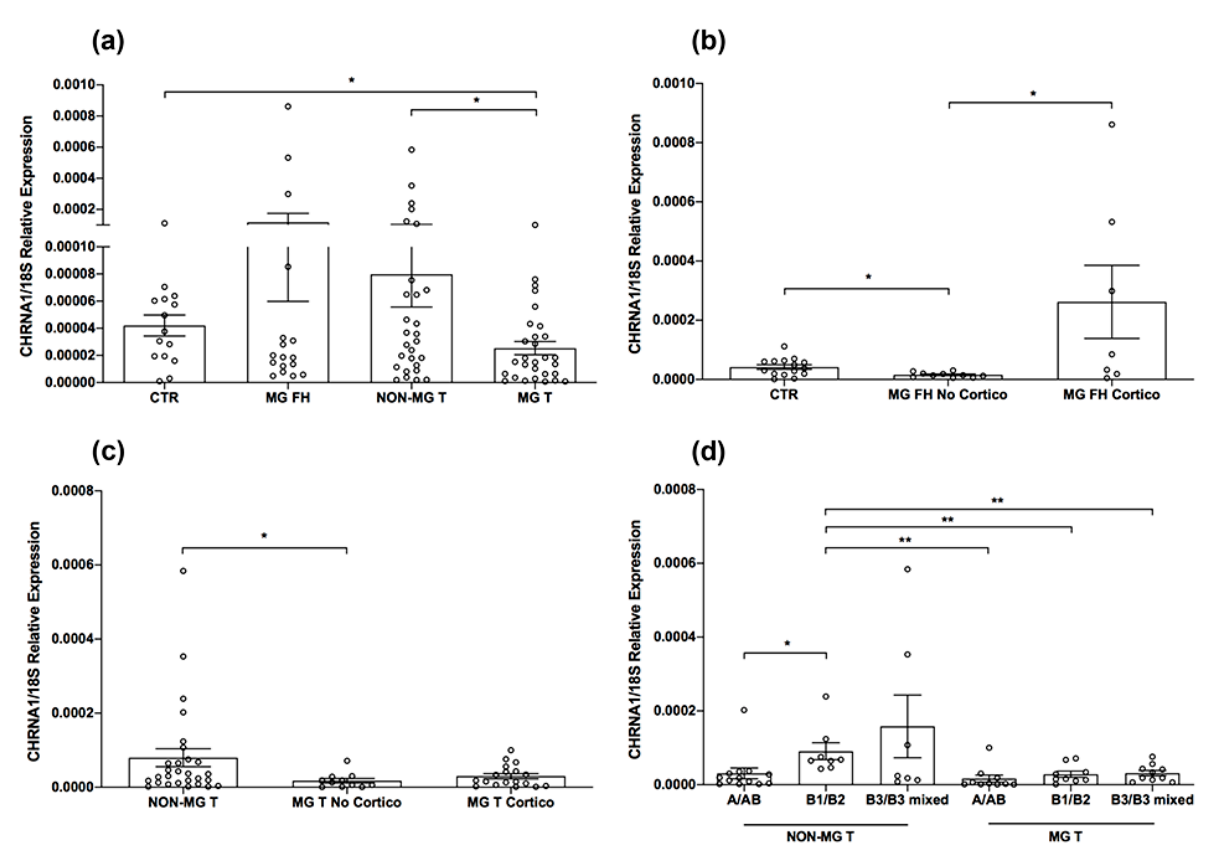
Figure 1. CHRNA1 expression in MG and control thymuses. ( a ) CHRNA1 mRNA levels were grouped as follows: normal thymuses ( n = 15, CTR); follicular hyperplastic MG thymuses from both corticosteroid-naïve and -treated patients ( n = 18, MG FH); thymomas from non-MG patients ( n = 33, NON-MG T); and thymoma from both corticosteroid-naïve and -treated MG patients ( n = 30, MG T). ( b ) CHRNA1 mRNA levels in MG FH thymuses from patients stratified in corticosteroid-naïve (MG FH No Cortico) and -treated (MG FH Cortico), according with corticosteroid treatment before thymectomy, compared to CTR. ( c ) CHRNA1 mRNA levels in thymomas from corticosteroid-naïve (MG T No Cortico) and -treated (MG T Cortico) patients, compared to NON-MG T. ( d ) CHRNA1 mRNA levels in NON-MG T and MG T stratified according with WHO thymoma type. In the graphs, CHRNA1 expression levels were expressed as relative values (2 − ∆ Ct × 100) that were normalized toward the endogenous 18S. Mann–Whitney test, * p < 0.05; ** p < 0.01. RYR1 expression was significantly reduced in hyperplastic and thymoma thymuses from corticosteroid-naïve, but not corticosteroid-treated, MG patients compared to control thymuses and non-MG thymomas, respectively (Figure 2a–c). In MG thymomas, RYR1 down-regulation mainly involved type A/AB tumor subset compared to the corresponding subset in non-MG tumors (Figure 2d). In both MG and non-MG thymomas, type A/AB tumors showed higher RYR1 mRNA levels than the histological B subtypes (Figure 2d). The TTN mRNA levels were also significantly lower in MG than non-MG thymomas, but not in hyperplastic MG compared to the control thymuses, with no differences observed between the corticosteroid-naïve and -treated patients (Figure 2e–g). As observed for RYR1 , the type A/AB subset showed lower TTN mRNA levels in MG compared to non-MG thymomas, but the differences were not statistically significant (Figure 2h). A slight, but not significant reduction in the TTN mRNA levels was also observed in the MG